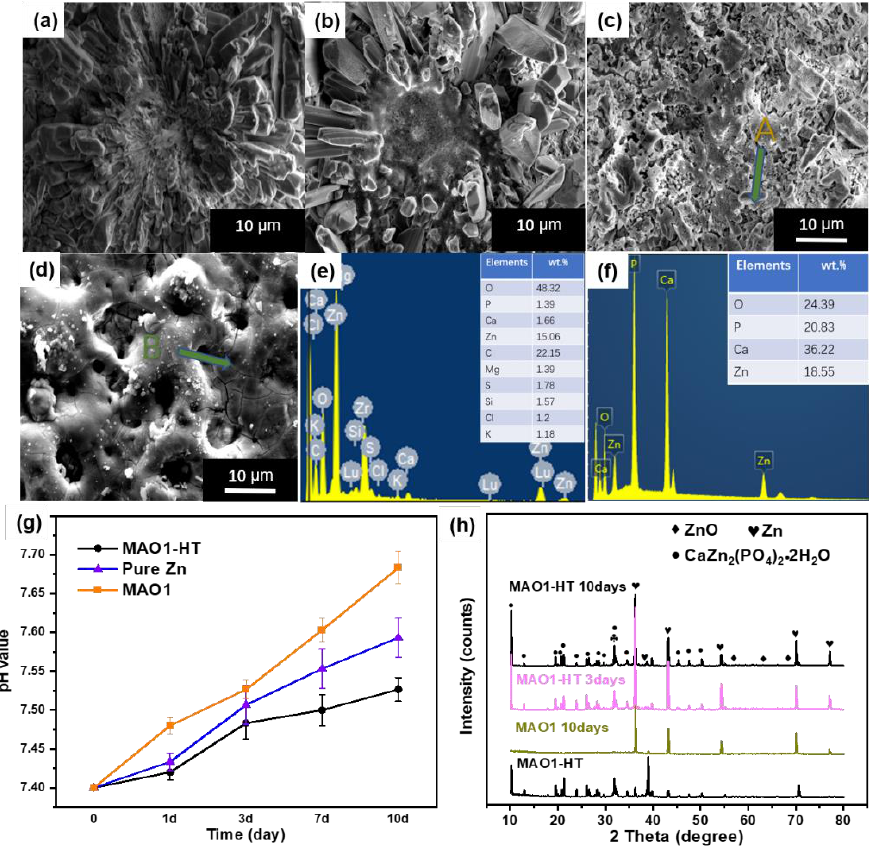
Figure 5. The degraded surface morphology and composition after immersion test in SBF for ( a ) MAO1−HT 1 day, ( b ) 3 days, ( c ) 10 days, ( d ) MAO1 coating immersed for 10 days, and ( e ) EDS analysis results of area B and ( f ) A, ( g ) evolution of pH values with immersion time, and ( h ) XRD patterns.